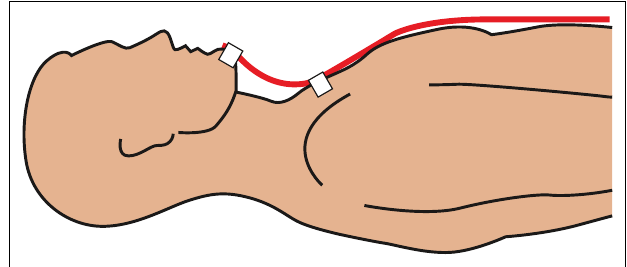
FIGURE 2 | Mounting of the bend sensor. The sensor (red) is fi xed to the chin and chest of the participant with adhesive tape (3M Durapore,